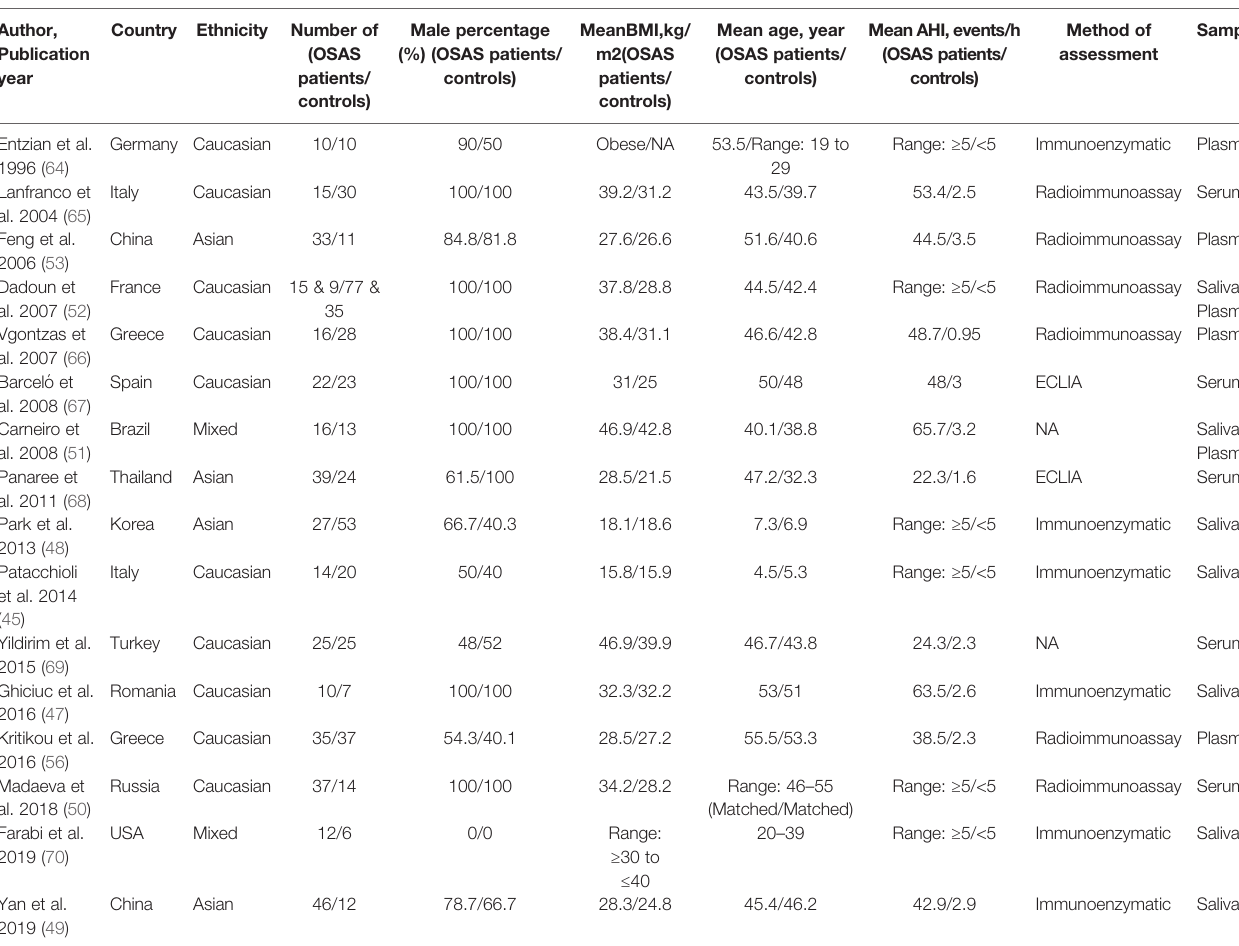
TABLE 1 | Characteristics of the studies included in this